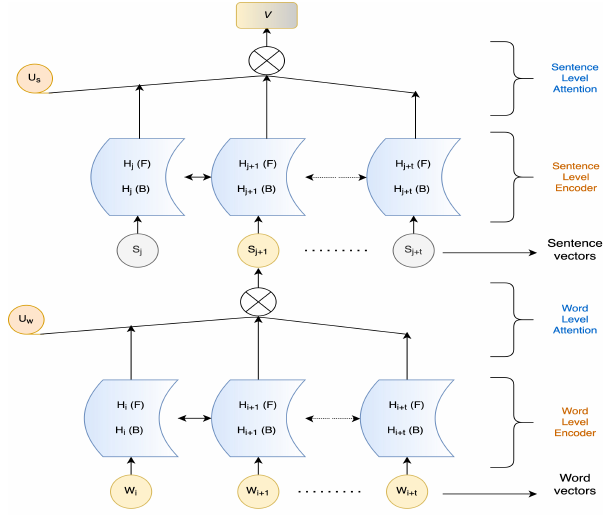
Figure 6. This figure depicts the architecture of Hierarchical Attention Network [5]. First, all the words are passed through Bi-directional GRU (F representing forward, B representing backward) to form the encoder. Then they are then passed to an attention network. These sets of words are then mapped to their corresponding sentence from the input, which goes through a similar process of Bi-directional GRU and Attention. The final vector V then represents the feature vector, which can be used to classify with softmax or combined with the feature vector of the visual stream to form a Two-stream